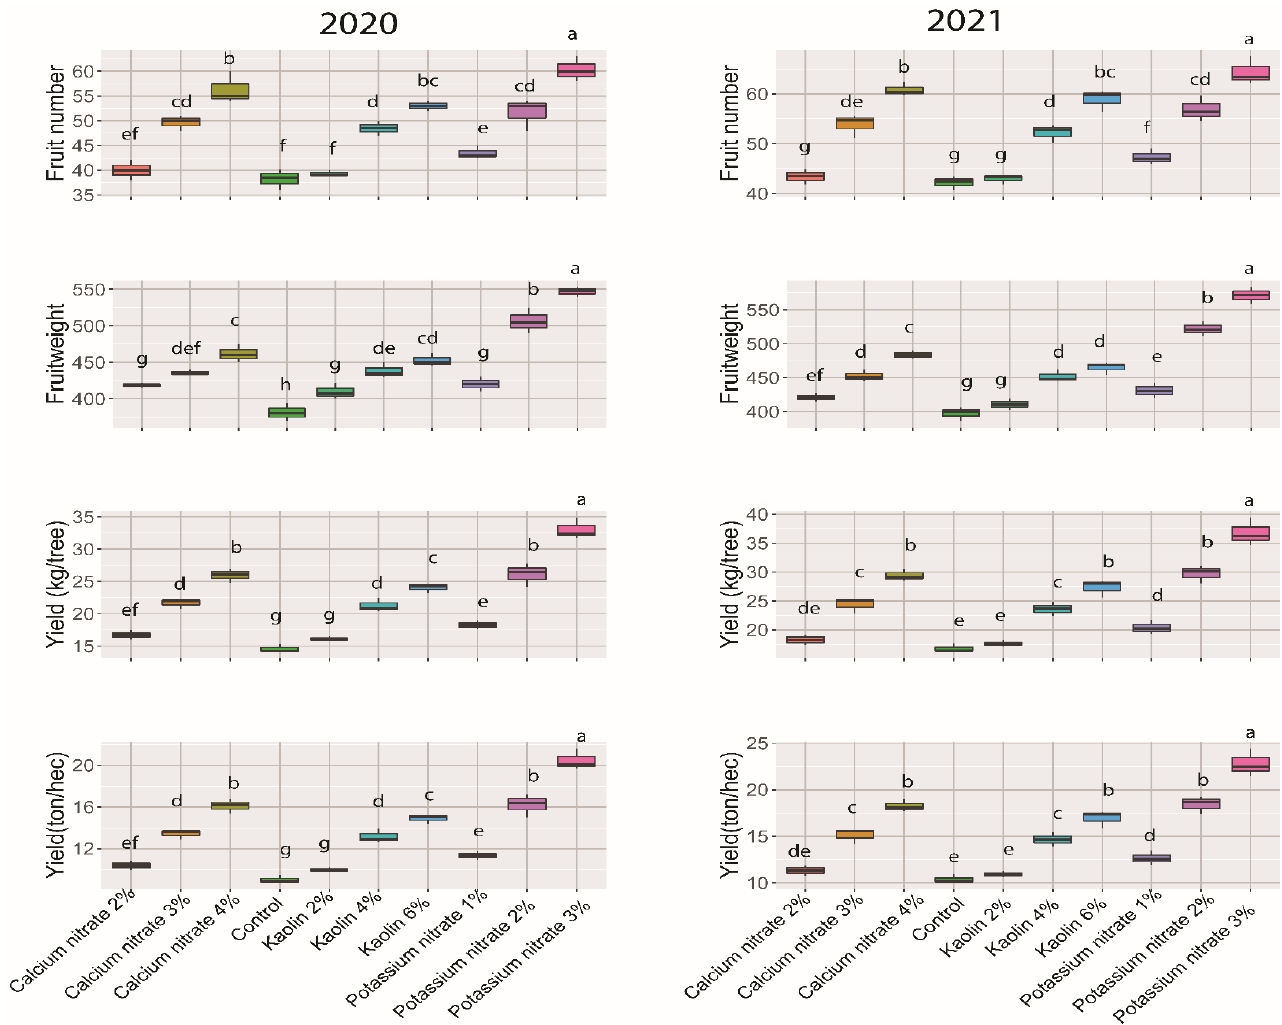
Figure 1. The of the foliar application of potassium nitrate, calcium nitrate and kaolin on the fruit number, fruit weight, fruit yield (kg/tree) and fruit yield (ton/hectare) of ‘Wonderful’ pomegranates during the 2020 and 2021 seasons. The same letters make it clear that there is no significant difference among treatments in the same column. Data are mean values of 10 replicates (10 trees).